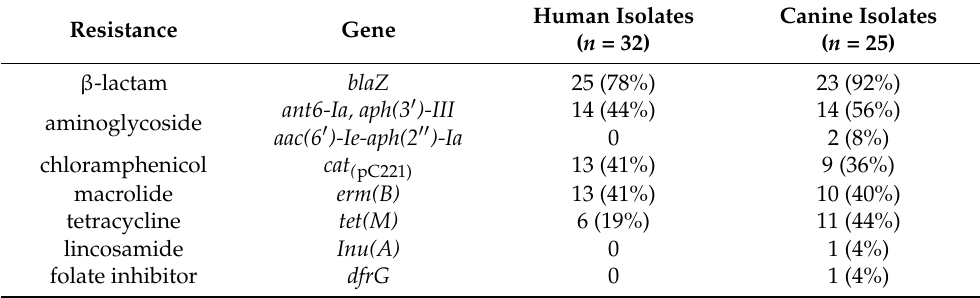
Table 1. Antimicrobial resistance genes in human and canine S. pseudintermedius isolates. Resistance